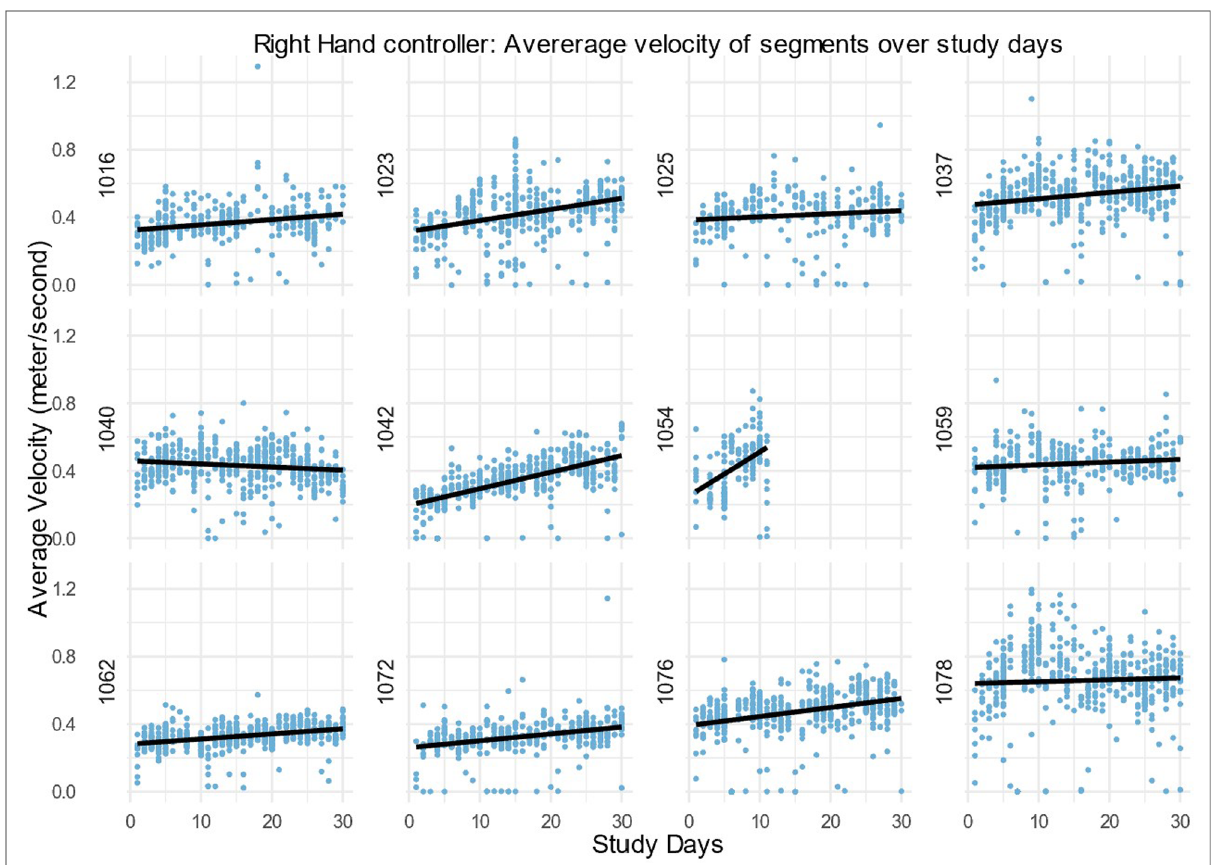
FIGURE 5 Average velocity in the right-hand controller of all action task segments within the 30 daily sessions (m/s) for all DTxP arm participants, with the regression line over the